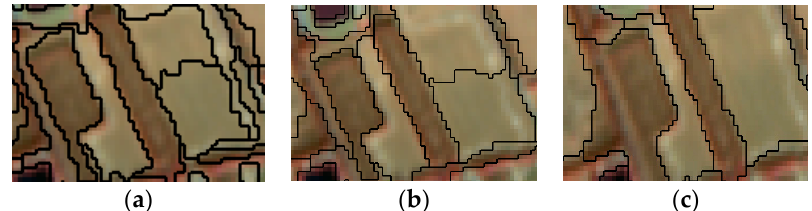
Figure 3. Different segmentation scale. ( a ) The weight of the shape factor is 0.2, the weight of the spectral feature is 0.8, the segmentation scale is 15. ( b ) The weight of the shape factor is 0.2, the weight of the spectral feature is 0.8, the segmentation scale is 25. ( c ) The weight of the shape factor is 0.2, the weight of the spectral feature is 0.8, the segmentation scale is 35.